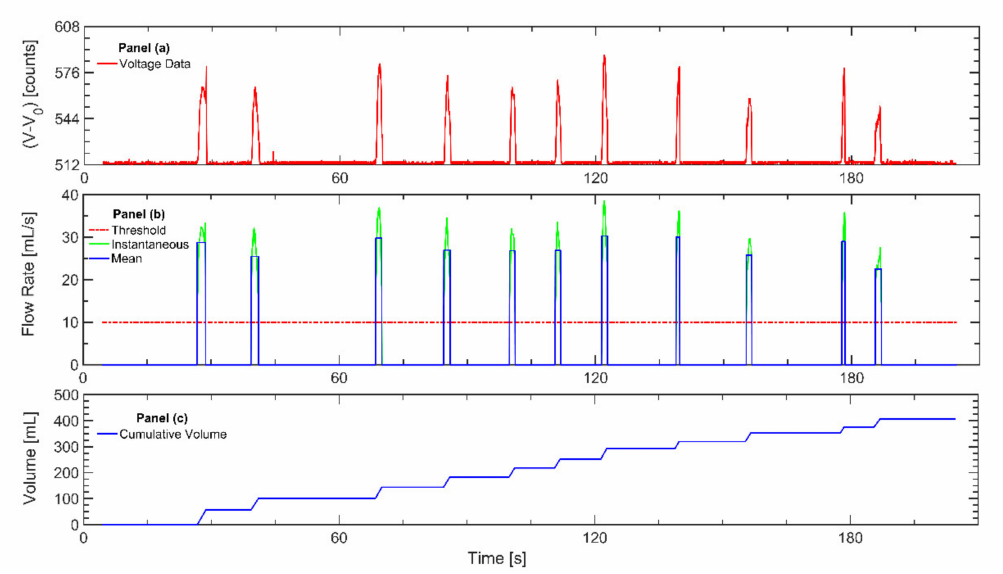
Figure 1. The figure illustrates the process for analyzing data recorded with the wPUM ™ cigarette monitor after each monitor is returned to the lab: ( a ) The raw voltage data (red line) is extracted from the monitor. ( b ) The voltage data are converted to instantaneous flow rate (green line) using the monitor-specific calibration curve. A minimum threshold of 10 mL / s (red line) is used to identify the onset and conclusion of pu ff s. The mean flow rate of each pu ff is determined (blue line). ( c ) The mean pu ff flow rate is integrated to estimate the cumulative session volume (blue